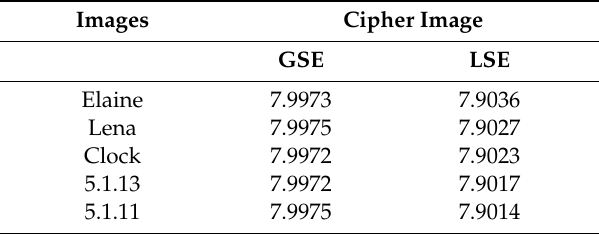
Table 5. GSE and LSE values of sample cipher